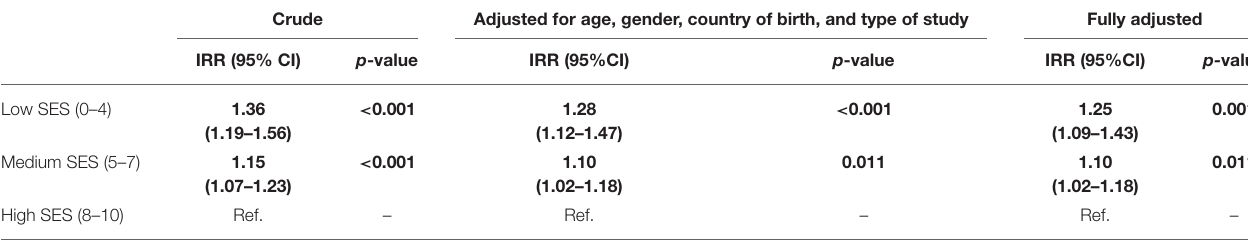
TABLE 3 | Association between subjective socioeconomic status and number of different negative experiences on social media. Crude Adjusted for age, gender, country of birth, and type of study